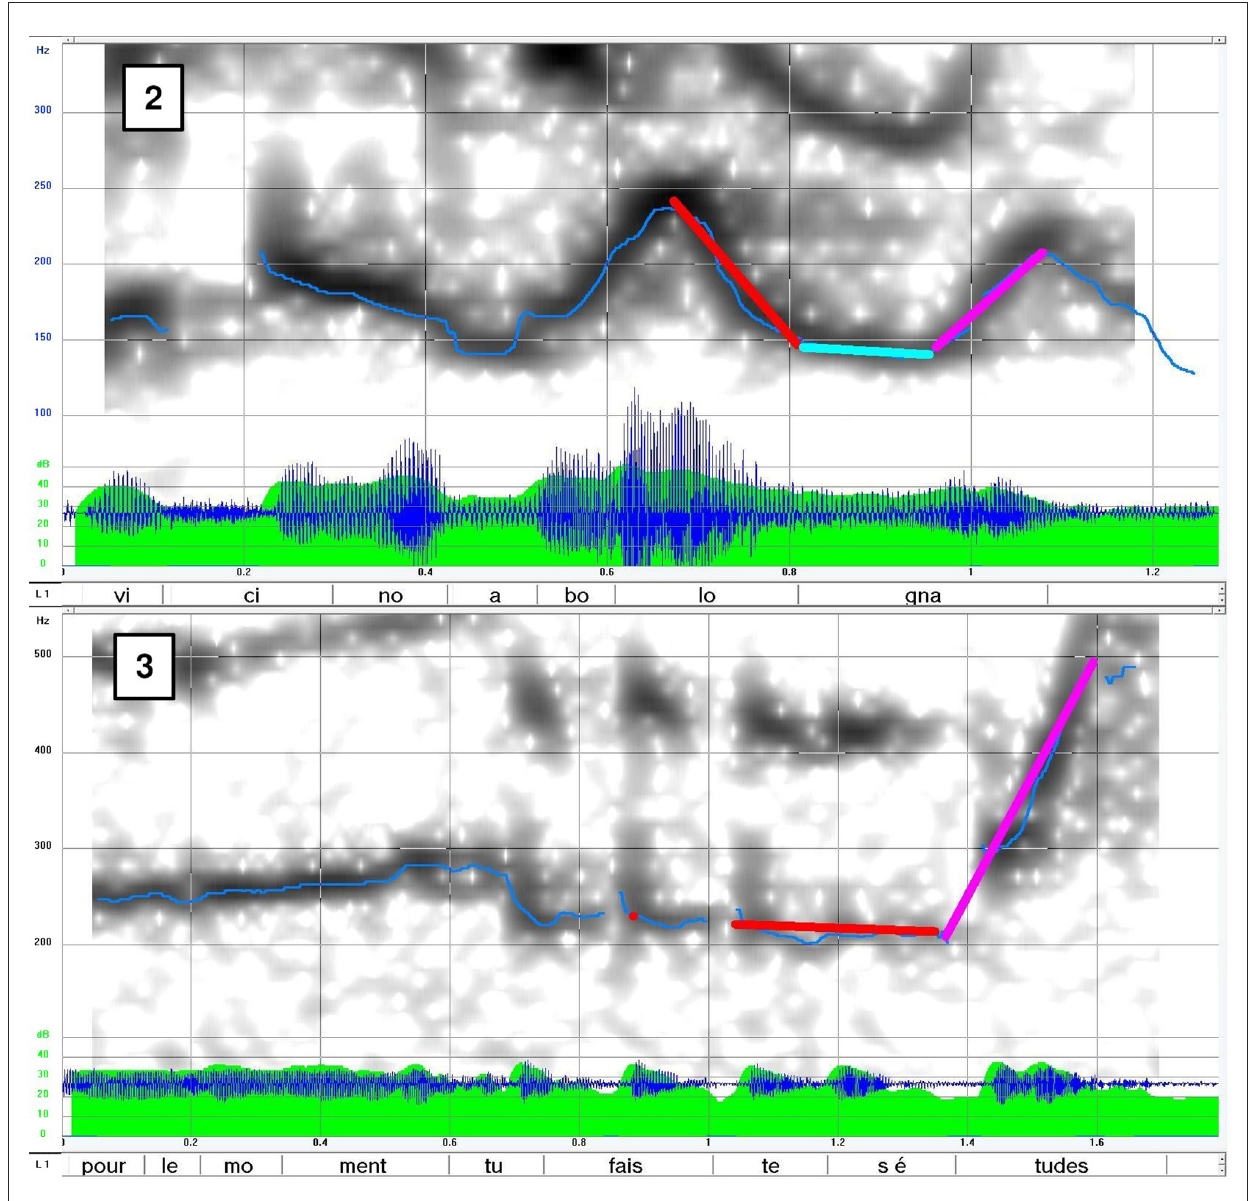
FIGURE4 Prototypic contours of Requests for confirmation in Italian and French (2; 3) (Supplementary Audio